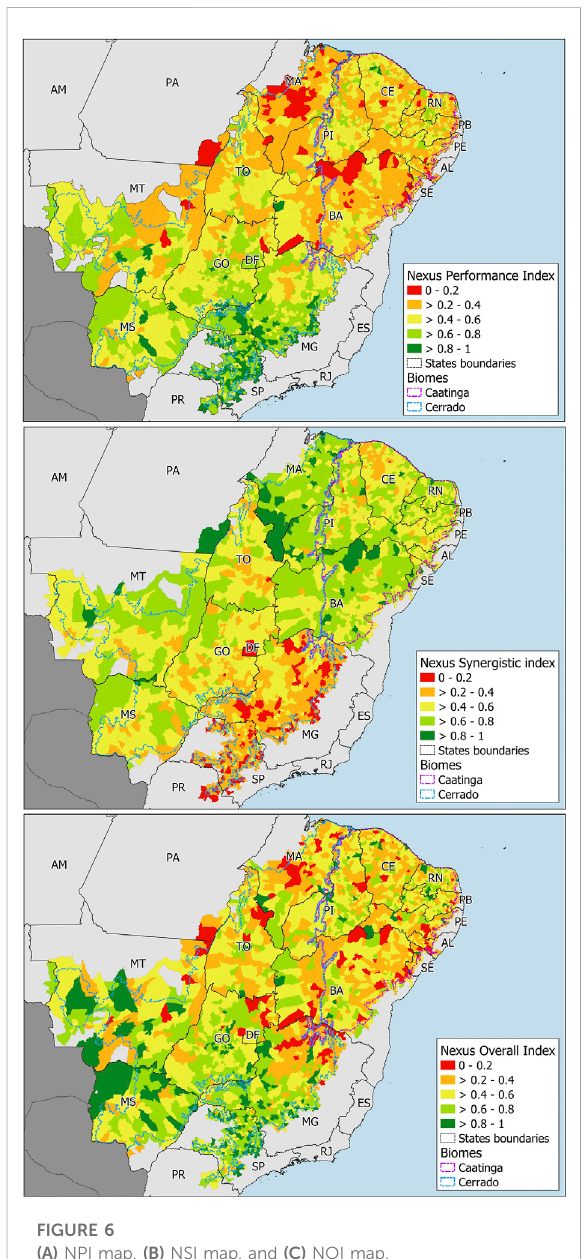
FIGURE 6 (A) NPI map, (B) NSI map, and (C) NOI